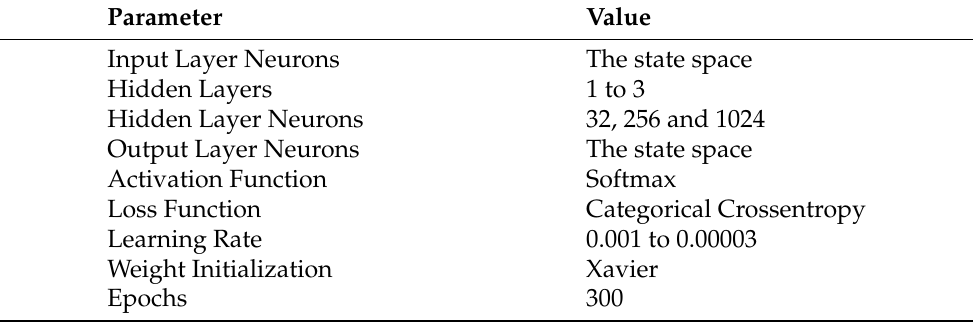
Table 4. DL model